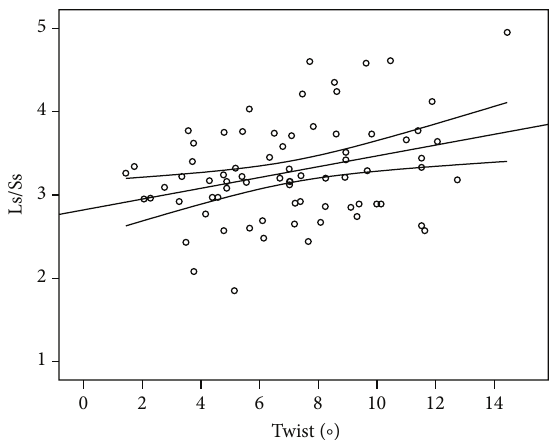
Figure 4: Diagram showing the positive correlation ( 𝑟 = 0.32 , 𝑃 = 0.005 ) between LV systolic twist and the index of acute LV remodeling systolic Ls/Ss ratio during temporary LV pacing for every pacing mode and site (LV: left ventricle, Ls/Ss: LV end-systolic long- (Ls) and short-axis (Ss) dimensions